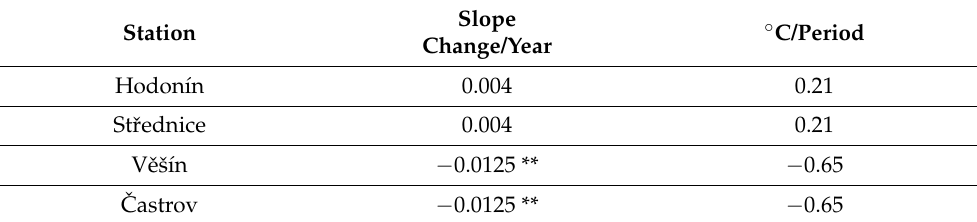
Table 7. Results of the M-K test of the minimum air temperature in the period of the cherry tree flowering in the period of